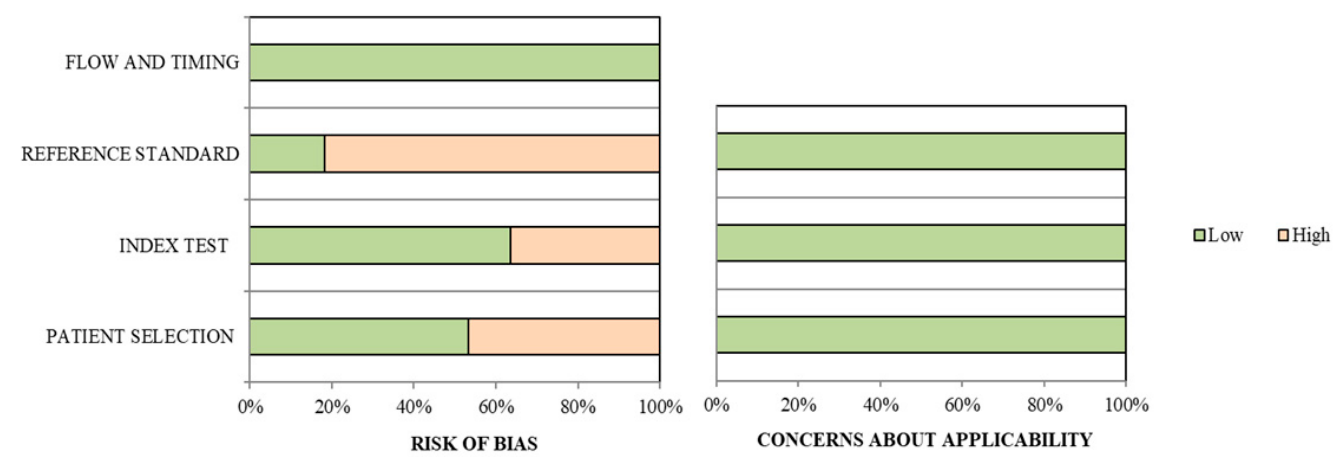
Figure 2. Study quality assessment. Overall quality assessment of the studies included in the systematic review according to QUADAS-2 tool [14].